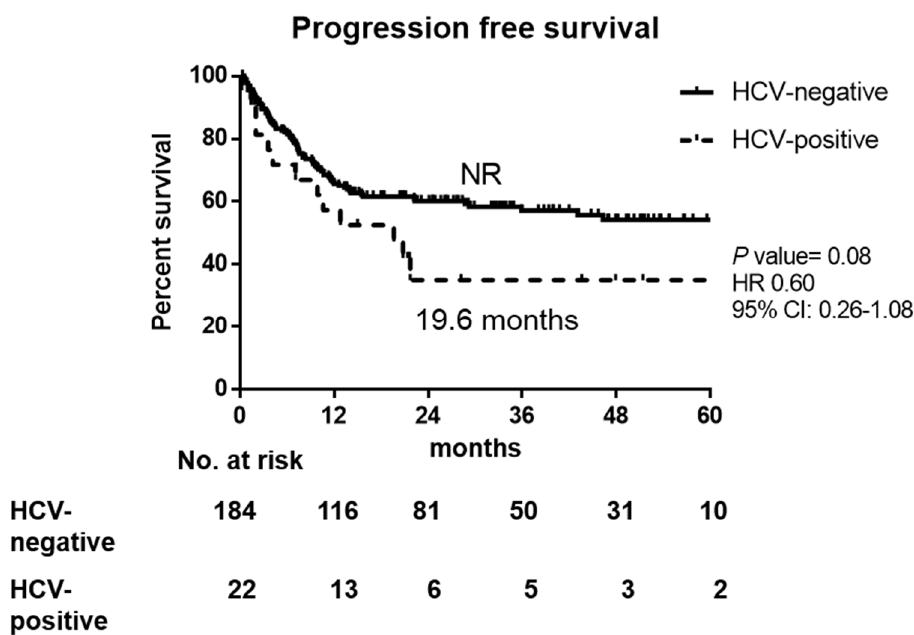
Figure 1. Progression-free survival of HCV-positive and HCV-negative DLBCL patients. NR: not reached, HR: hazard ratio, CI: confidence interval.